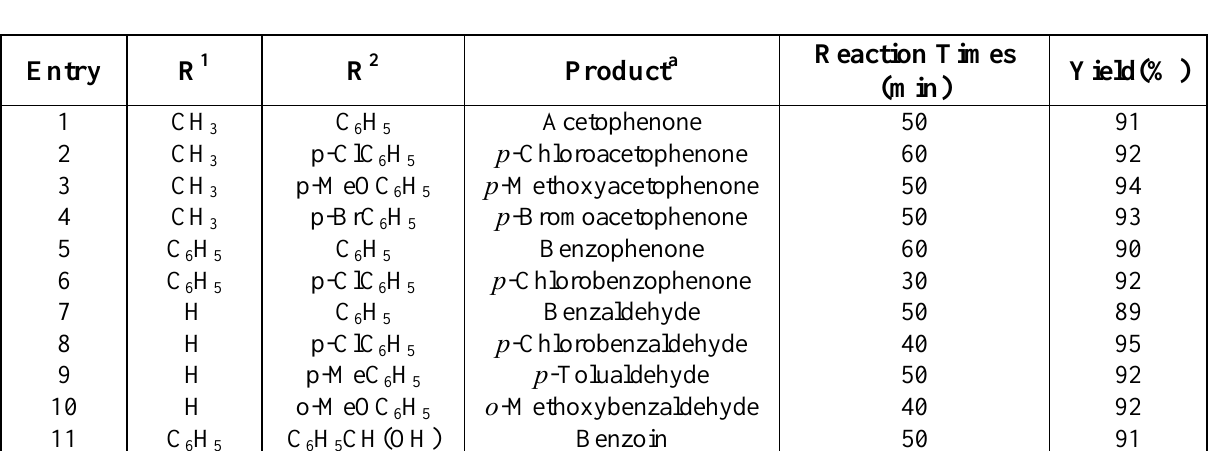
Table 1. Cleavage of 2,4-dinitrophenylhydrazones with BNBTS under microwave